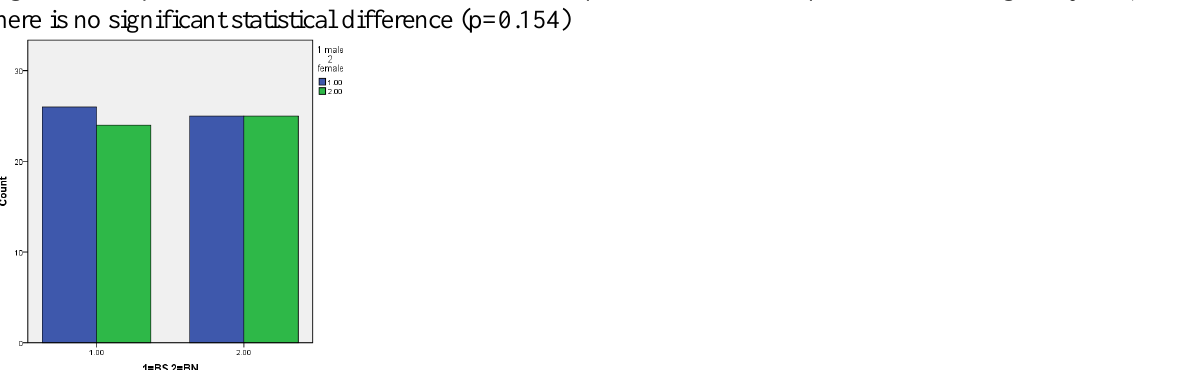
Figure (2) Bupivacaine with normal saline versus bupivacaine with nefopam in term of gender, there is no significant statistical difference (p=0.421).